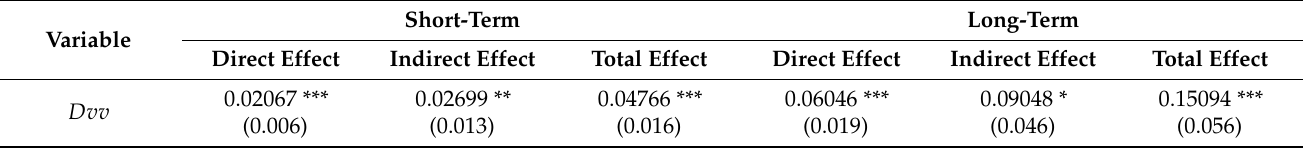
Table 4. Decomposition effects of dynamic spatial Durbin model in short- and